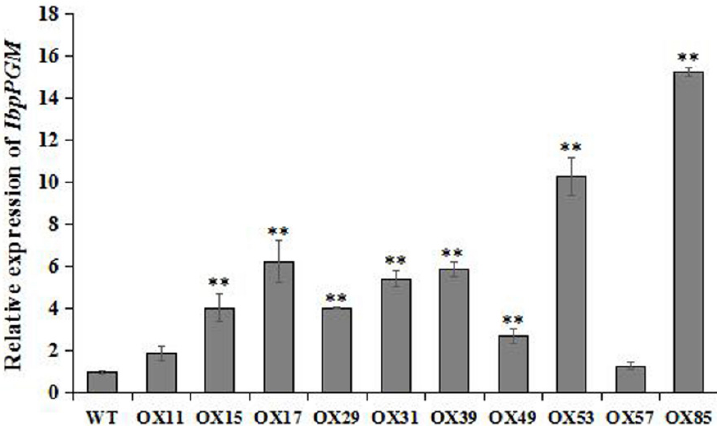
Figure 6. Relative expression levels of IbpPGM in the IbpPGM -overexpressing (OX) transgenic and wild-type (WT) sweet potato lines. ** indicates a significant difference versus WT at p < 0.01, based on Student’s t -test.